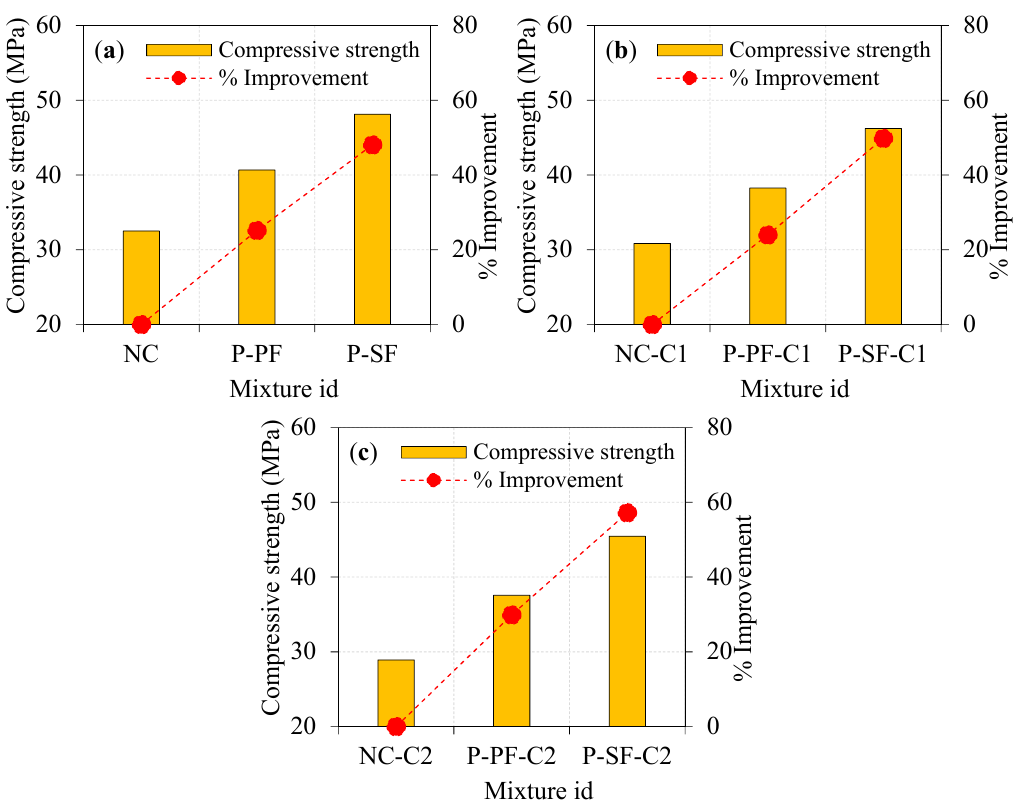
Figure 9. Effect of fibre type on compressive strength: ( a ) natural aggregate, ( b ) singly coated aggregate, ( c ) doubly coated aggregate.